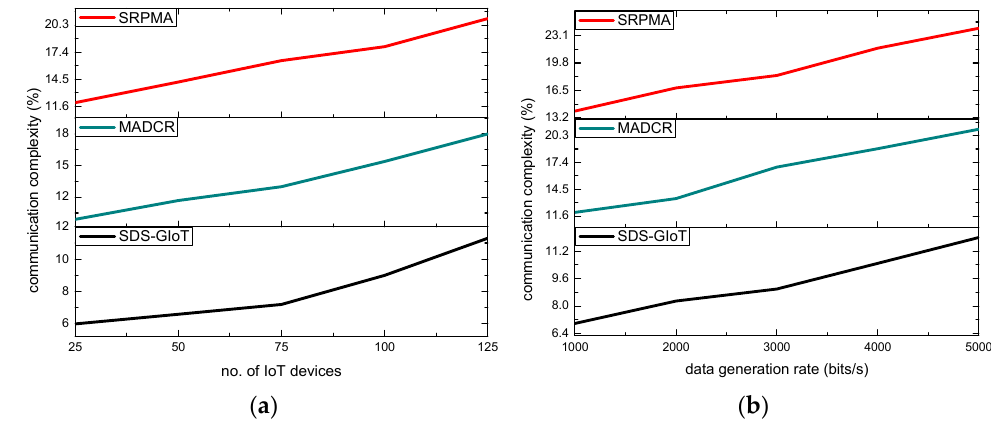
Figure 6. Scenarios for varying IoT devices and data generation rates in terms of communication complexity. ( a ) communication complexity and IoT devices. ( b ) communication complexity and data generation rates.